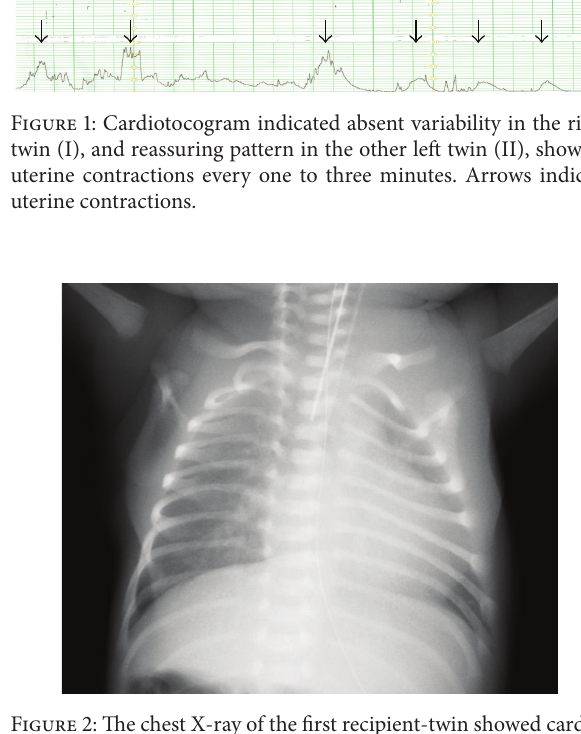
Figure 2: The chest X-ray of the first recipient-twin showed cardiac dilatation: the cardiothoracic ratio was